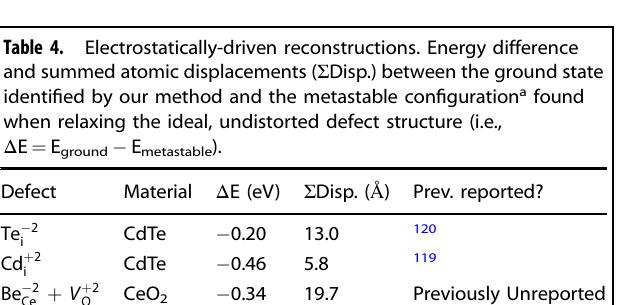
a Metastable and ground state structures with bond distance labelling shown in Supplementary Fig. 19.